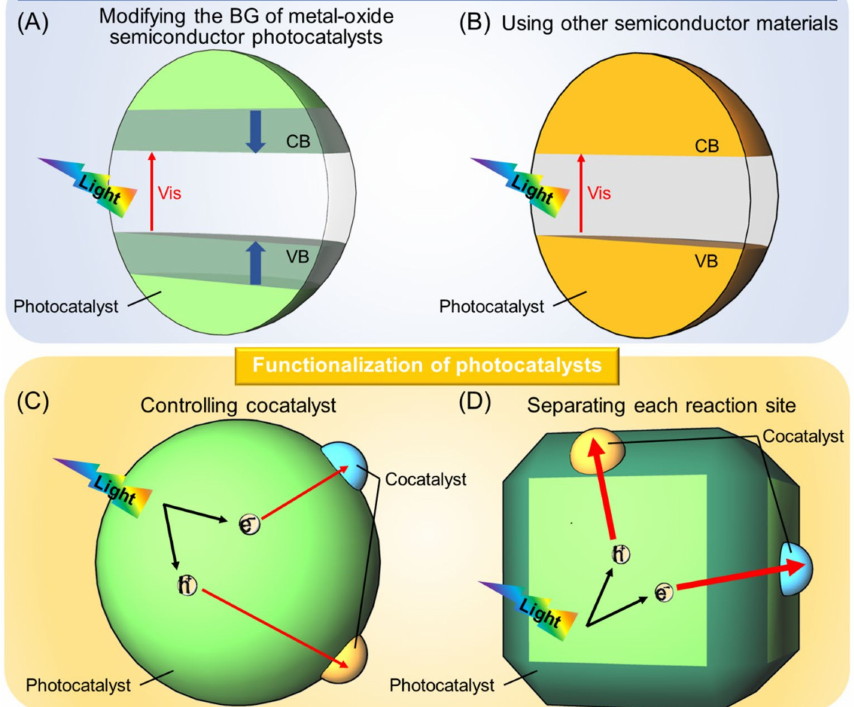
Figure 5. Schematic illustrations of the contents of Sections 2–4 in this review. Creation of Vis- light-driven water-splitting semiconductor photocatalysts by ( A ) modifying the BG of metal oxide semiconductor photocatalysts (UV-light-driven water-splitting photocatalysts; Section 2.1) and ( B ) us- ing other semiconductor materials (Section 2.2). Functionalization of photocatalysts by ( C ) controlling the cocatalysts (Section 3) and ( D ) separating each reaction site (Section